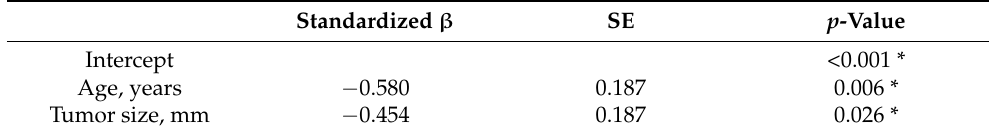
Table 4. Parameters of predictors incorporated into the multiple linear regression model for visfatin serum concentrations in patients with adrenocortical